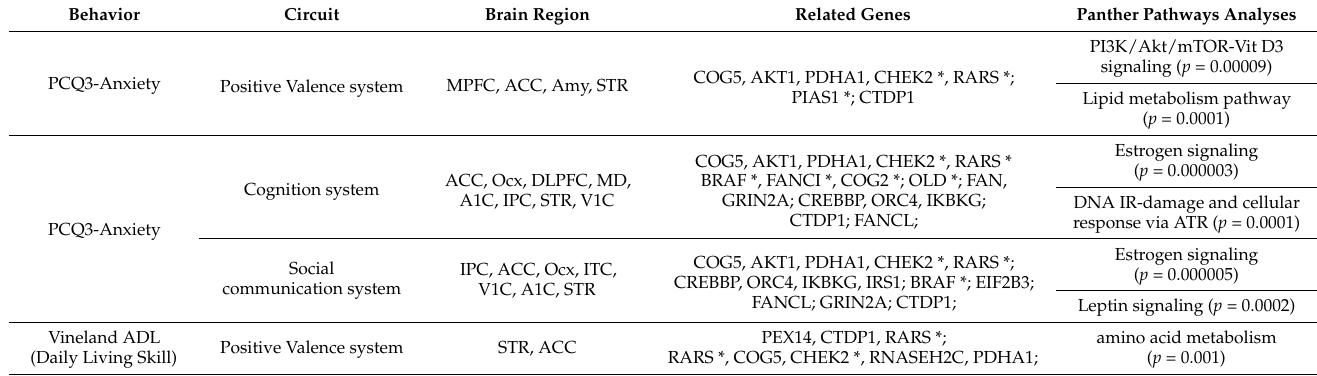
Table 3. Panther Pathways Analysis of Gene Variants expressed in RDoC Neural